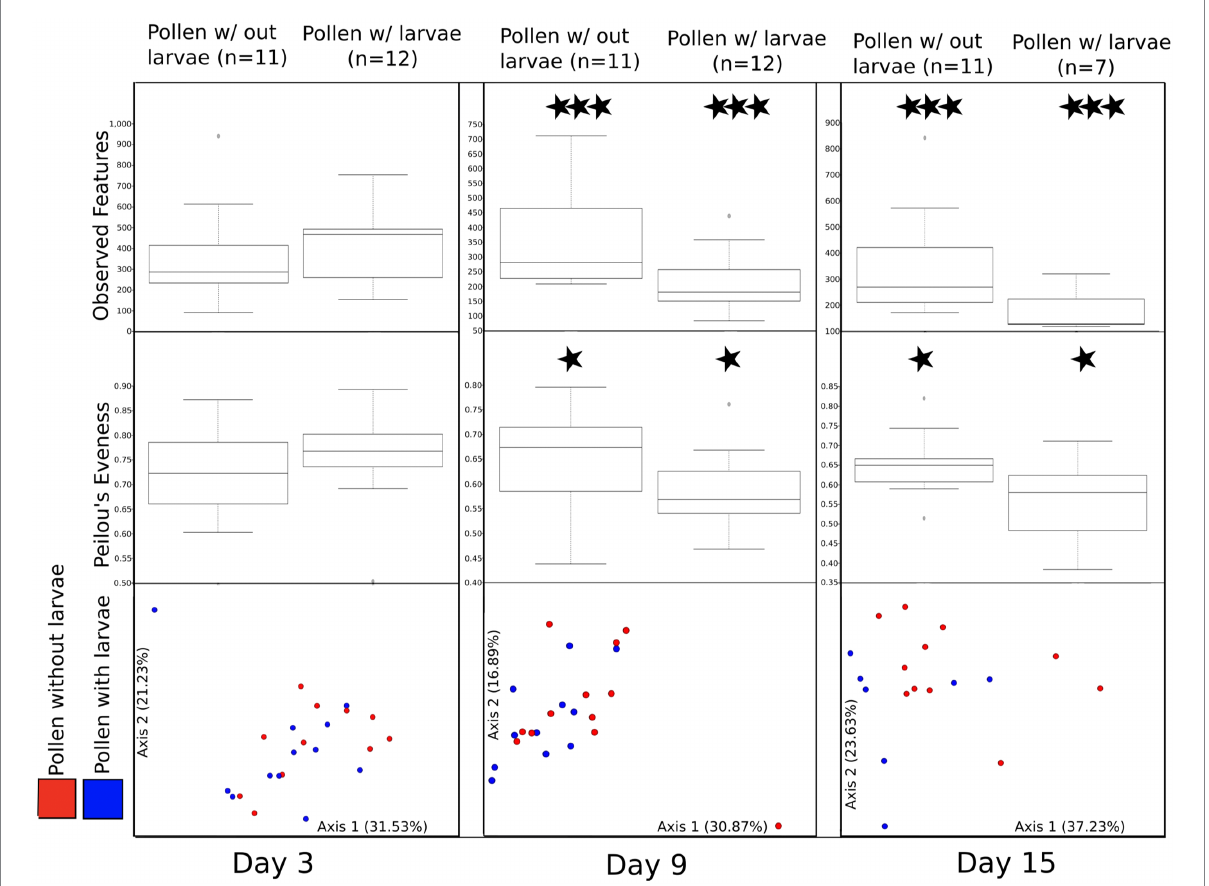
FIGURE 4 A comparison of bacterial diversity between pairs of pollen masses that were combined and then separated returning one larva to each pair. All figures (observed features, Peilou’s evenness, and beta diversity) are summarized by three experimental time points (day 3, day 9, and day 15). Moderately significant is denoted by one star (*) and significant differences are denoted by three stars